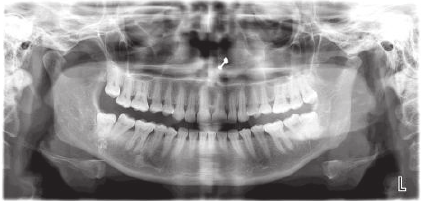
Figure 4: Panoramic radiograph revealing calcifications superim- posed over the partially erupted lower right third molar.